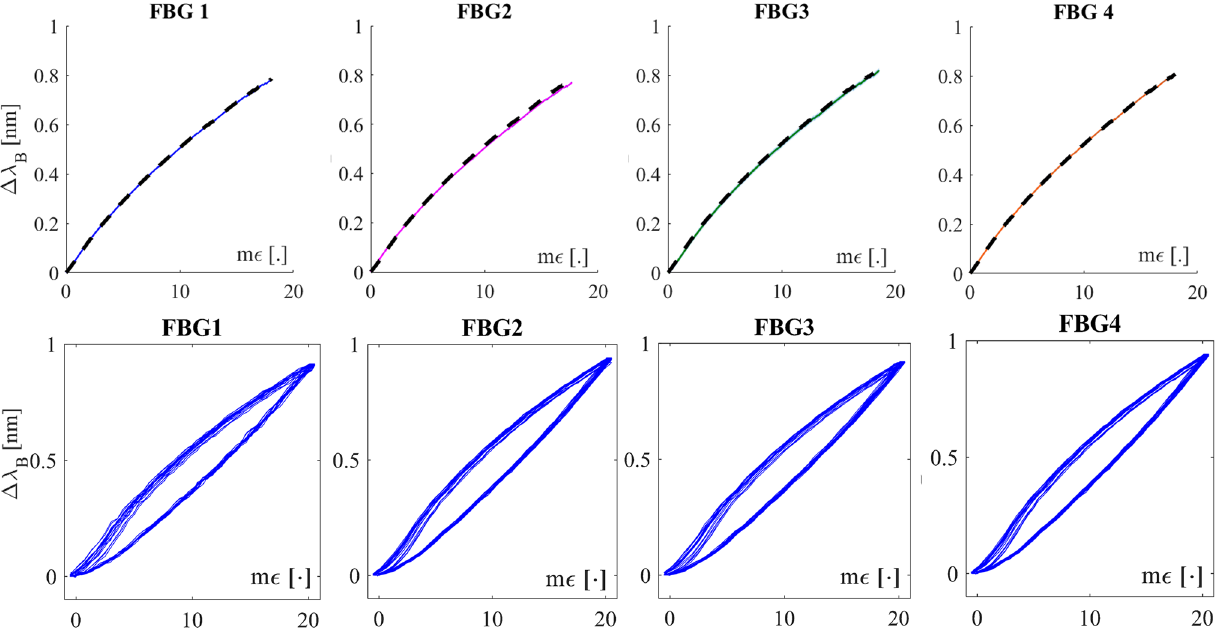
Figure 2. The calibration curves (experimental data with fitting curves in dotted line and shadowed uncertainty) and the hysteresis loops at velocities mimicking 60 bpm for FBG1, FBG2, FBG3, and